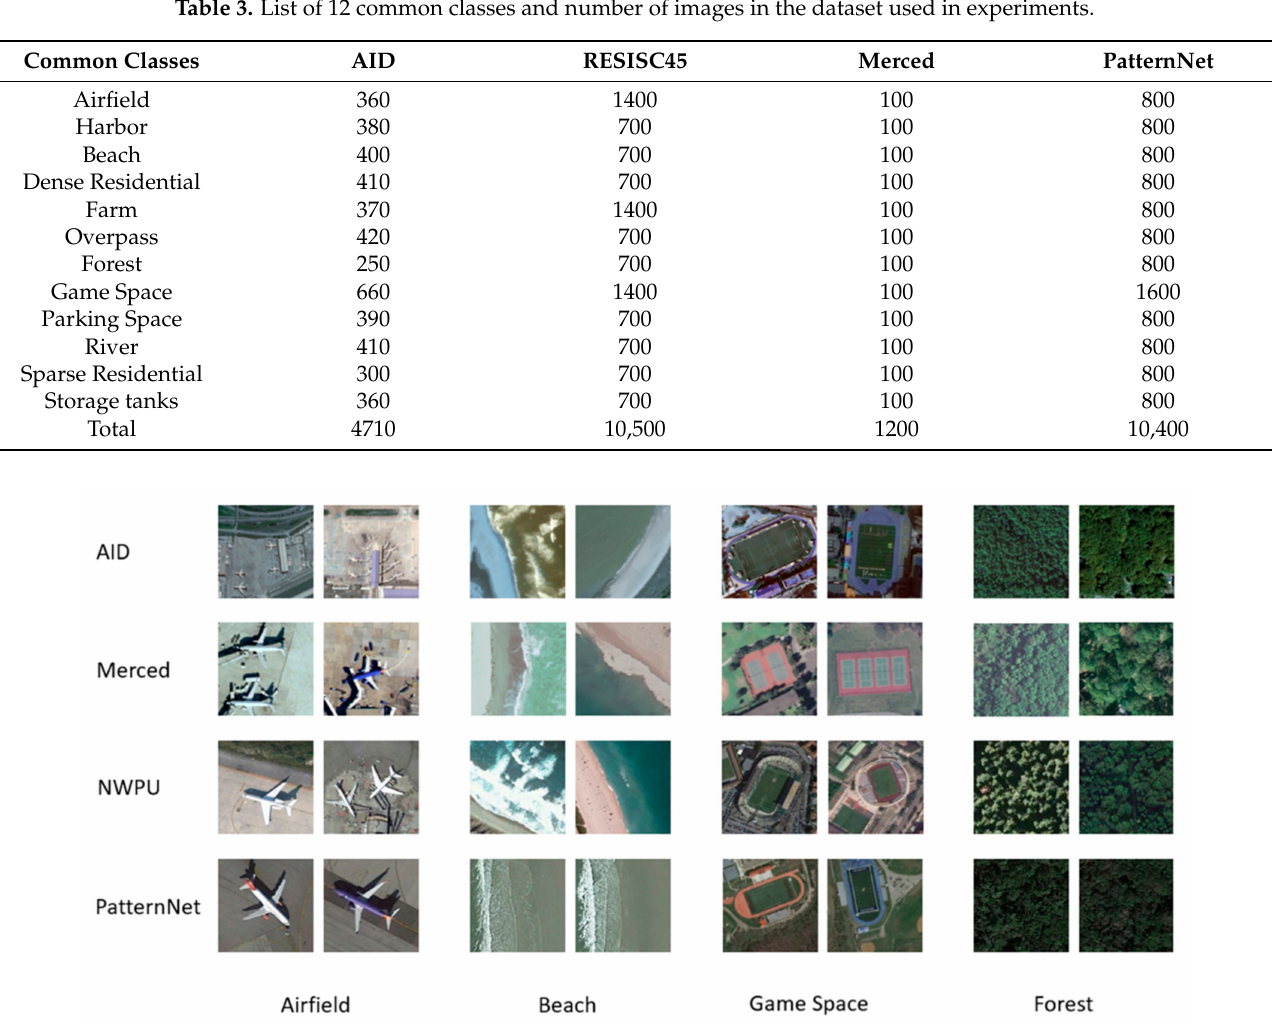
Table 3. List of 12 common classes and number of images in the dataset used in experiments.